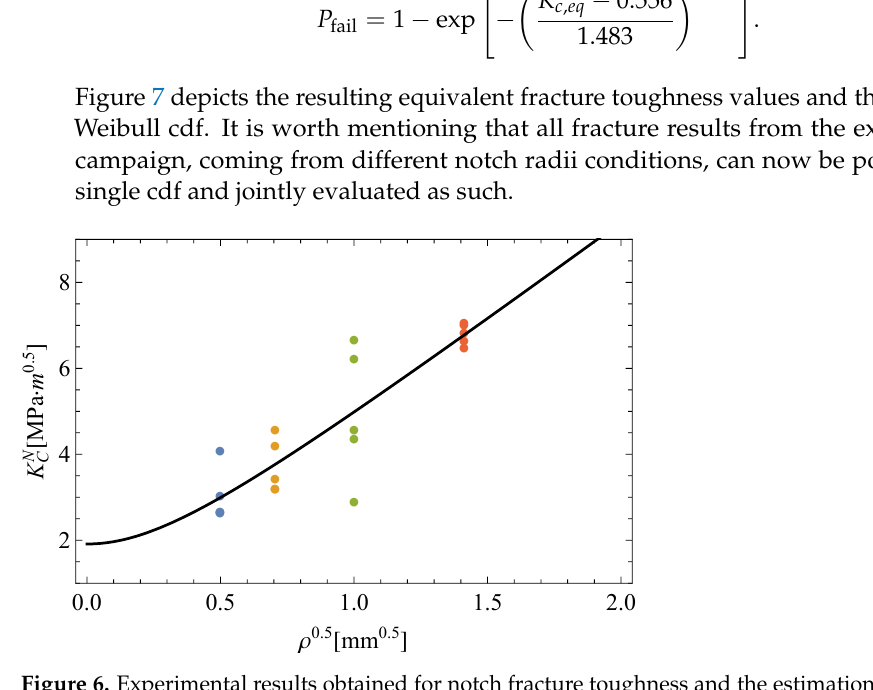
Figure 6. Experimental results obtained for notch fracture toughness and the estimation according to the TCD method.